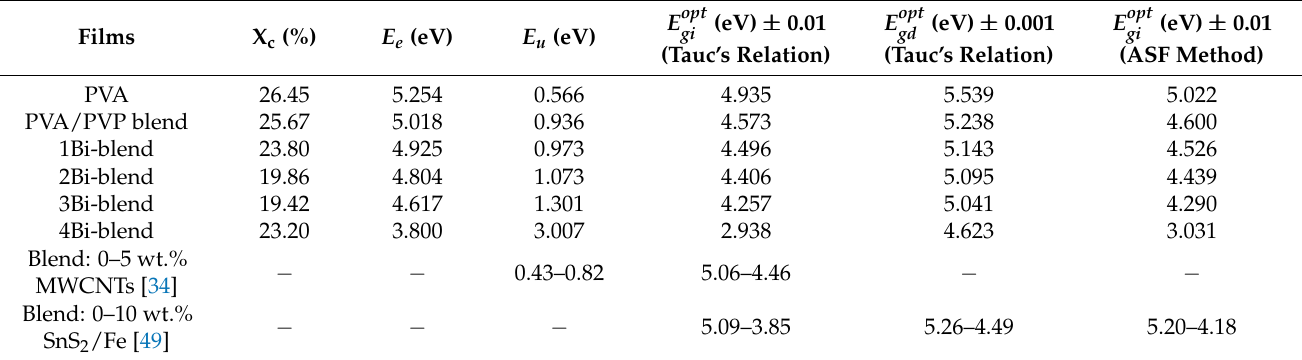
Table 1. Absorption edge, Urbach energy, and optical bandgap of Bi-blend hybrid